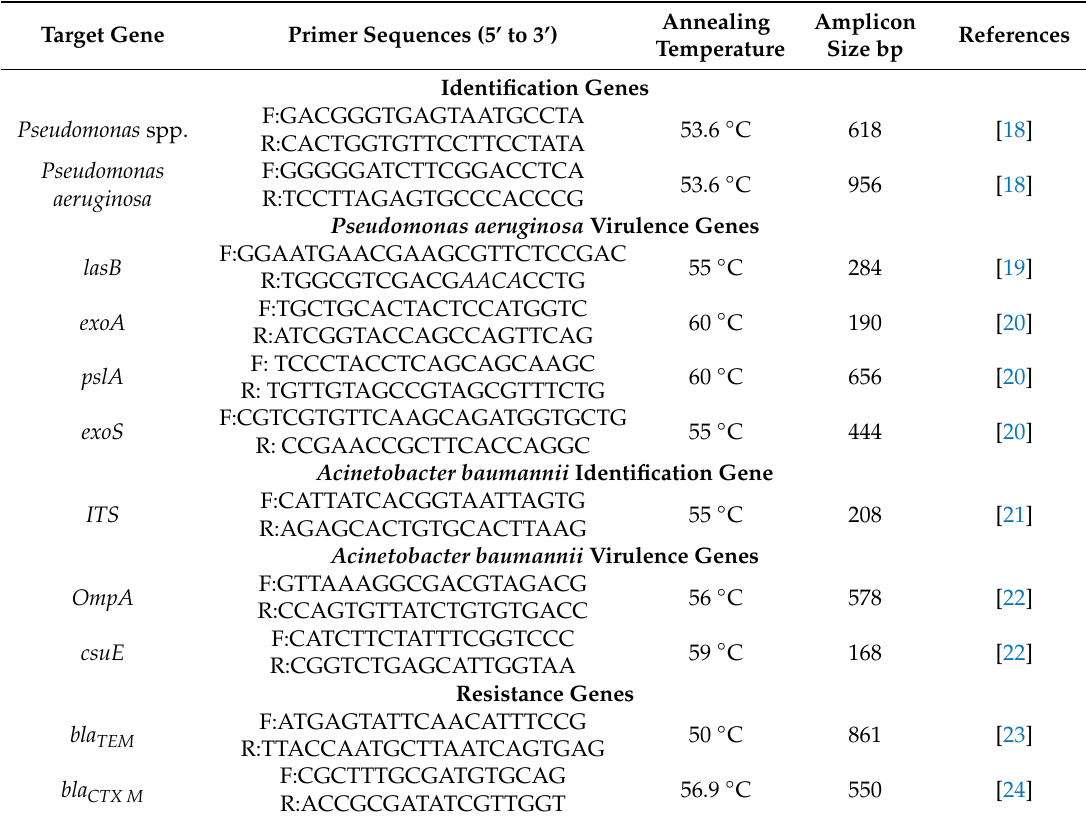
Table 1. List of primers and polymerase chain reaction (PCR) conditions used in this study. Target Gene Primer Sequences (5’ to 3’) Identification Genes Pseudomonas